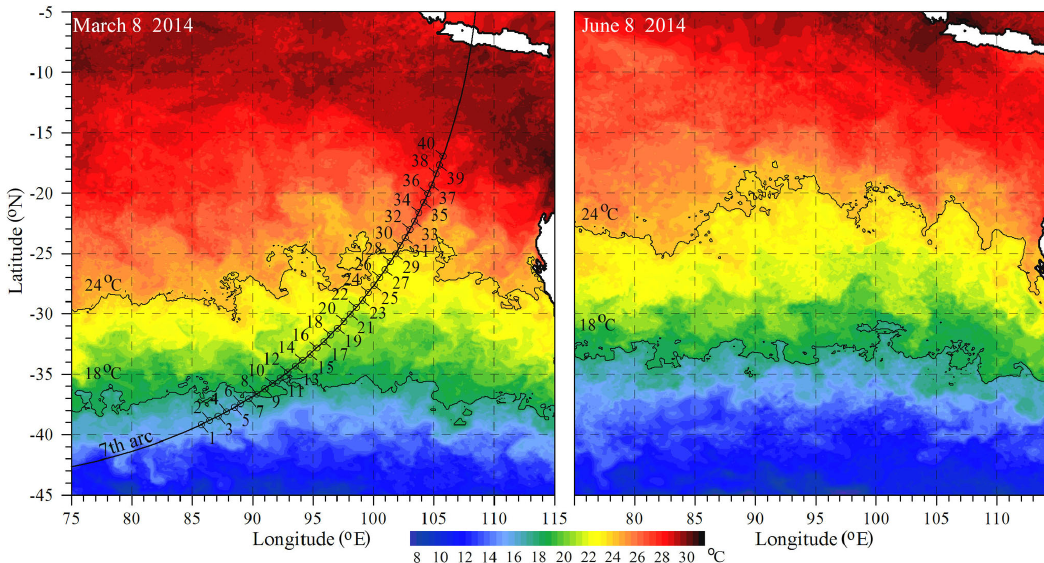
Figure 4. Locations of the selected hypothetical origins on the seventh arc and snapshots of the sea surface temperatures.